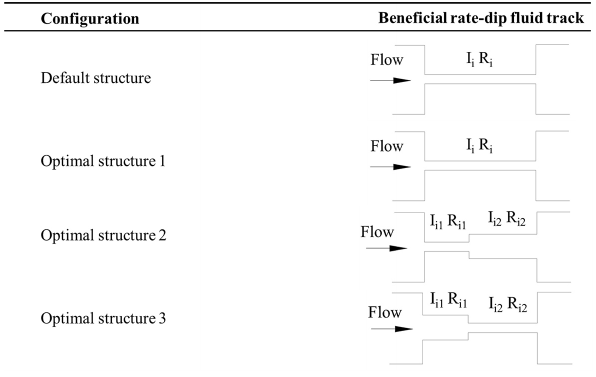
Figure 6. Rate-dip channels with different